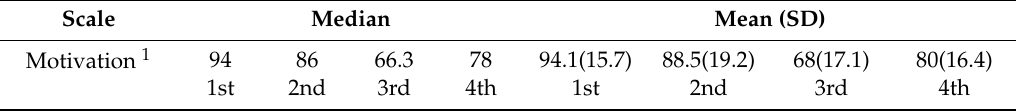
Table 5. Motivation towards mathematics according to the students’ academic level. Scale